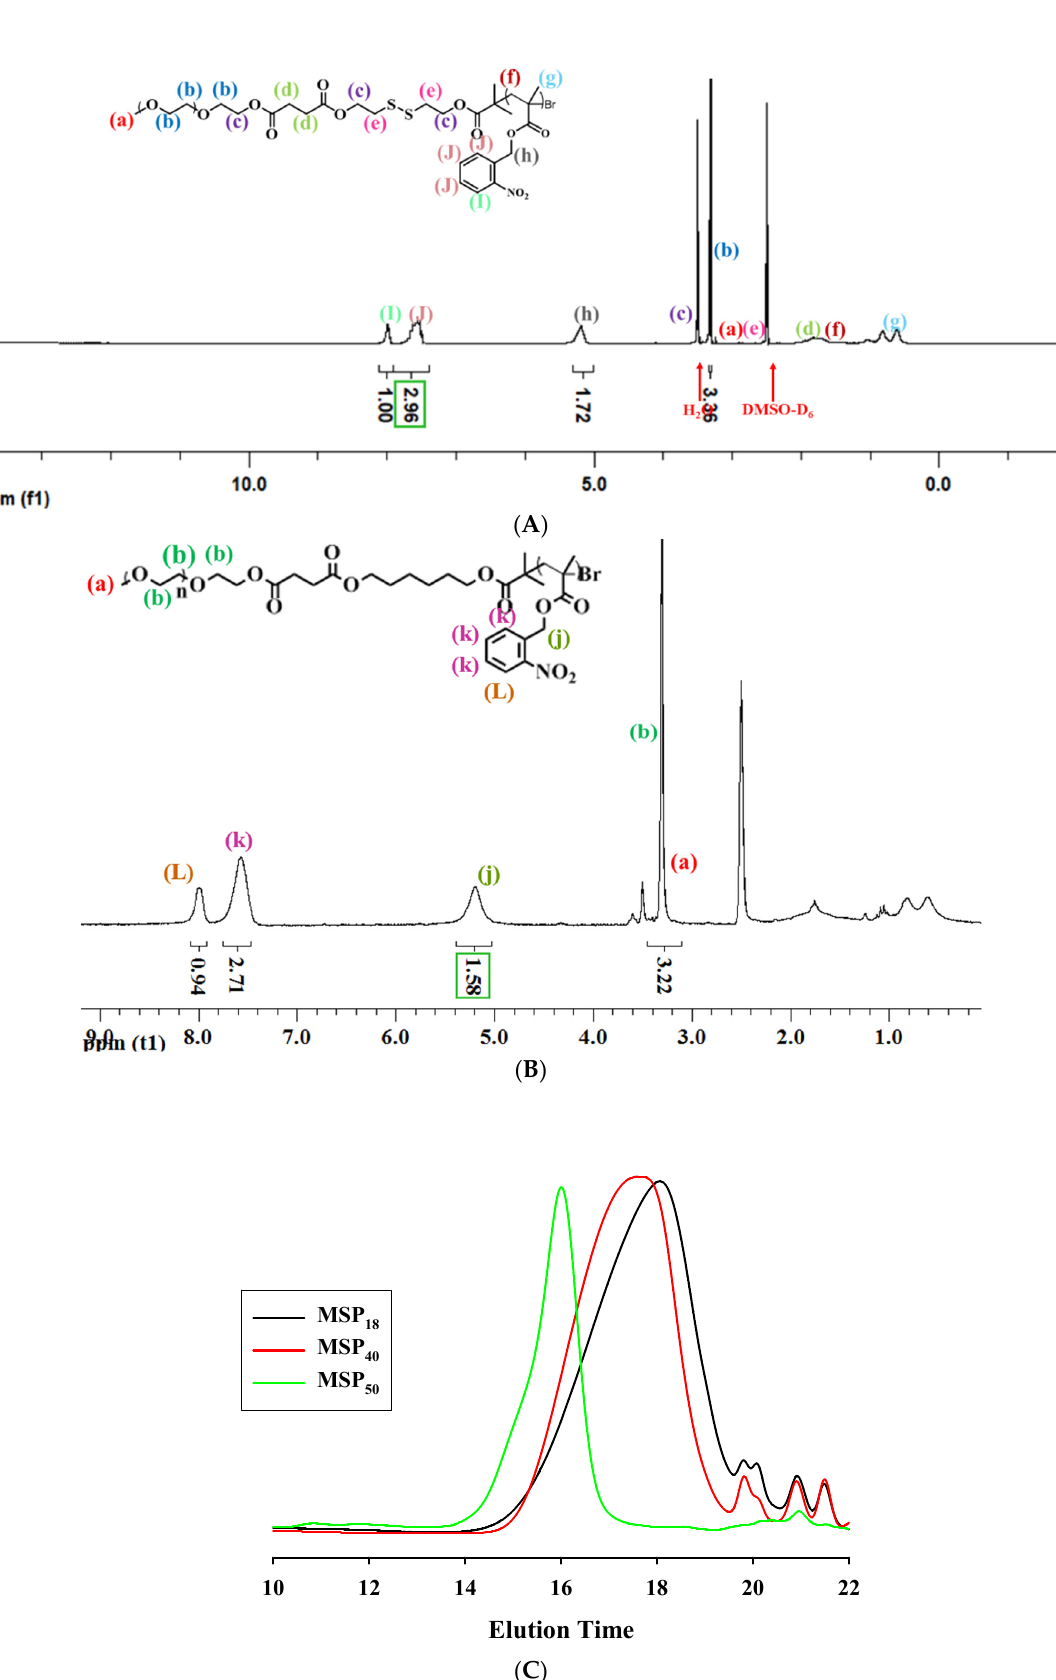
Figure 1. 1 H-NMR spectra of MSP 50 ( A ) and MCP 50 ( B ) and size exclusion chromatography profiles of three mPEG-SS-pONBMA copolymers with different ONBMA lengths ( C ).